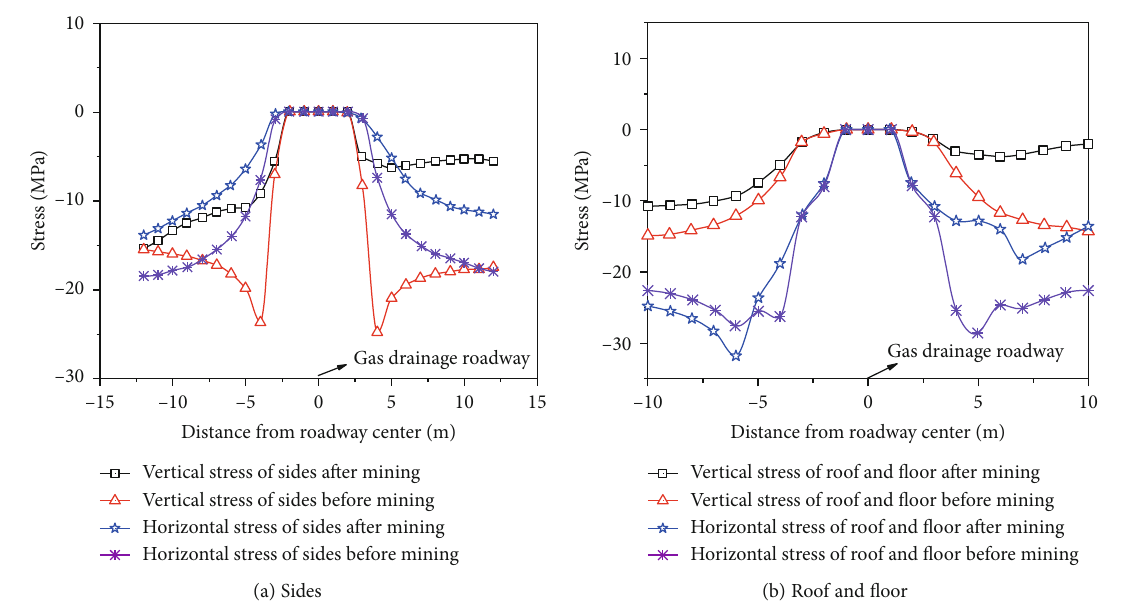
Figure 20: Stress distribution curve of roadway surrounding rock after